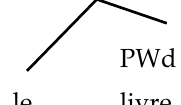
The French clitic is both directionally (left, not right) and prosodically (free, not affixed) distinct from the English pronominal clitic. In their nominal morphosyntax, however, both languages share a similar prosodic free clitic structure, that of the leftward article plus noun as in (4). French/English PPh